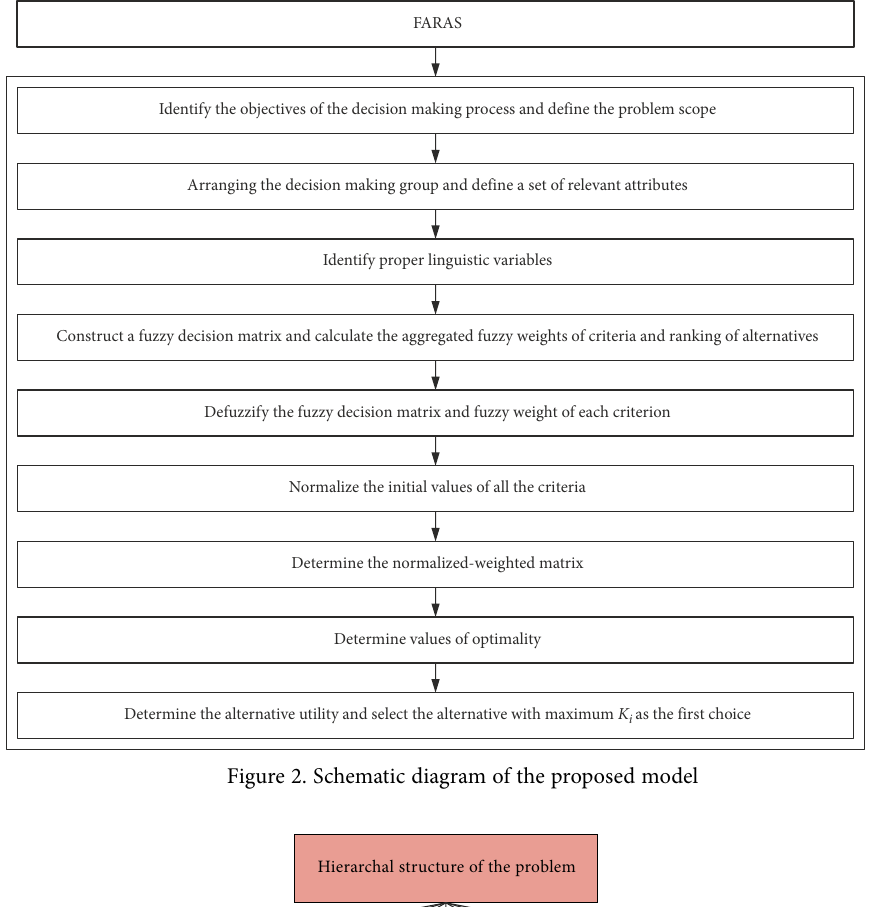
Hierarchal structure of the